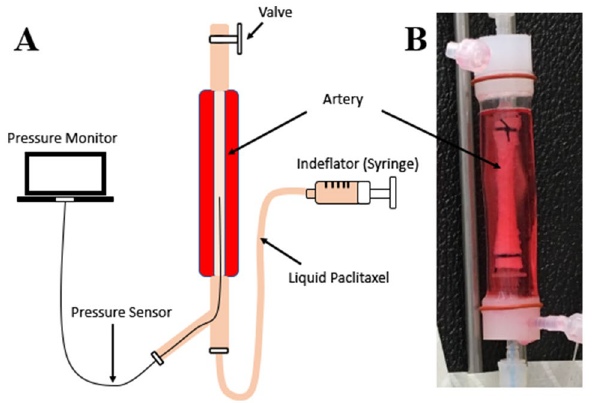
Figure 1. Ex vivo experimental setup. ( A ) Schematic diagram of the ex vivo setup. A pressure sensor inserted into the lumen continuously monitored pressure during the delivery of the liquid solution. ( B ) Representative image of a harvested porcine carotid artery housed in the bioreactor